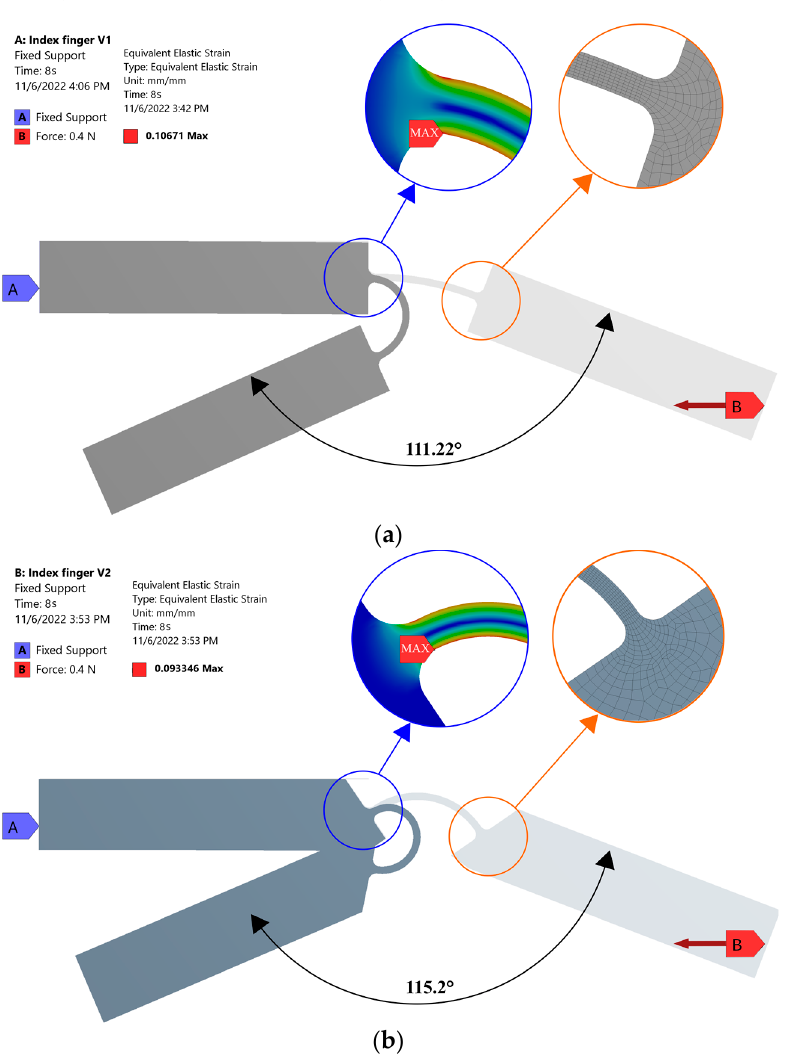
Figure 6. Boundary conditions and finite element mesh, maximal bending angle, and maximal strain of: ( a ) Curved flexure hinge with a 21-degree bend and ( b ) Curved flexure hinge with a 90-degree bend.